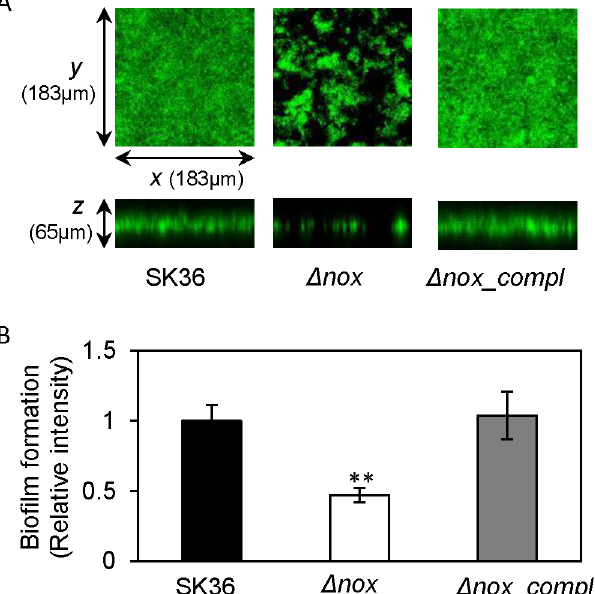
Fig 1. Reduction in biofilm formation in the nox mutant as assessed by confocal laser scanning microscopy. A, biofilm formation on a polystyrene surface detected using a confocal laser scanning microscope. B, quantification of biofilm formation in A. Δ nox , the nox mutant; Δ nox_compl , the complemented strain of the nox mutant. ** , significant difference with P < 0.01 between SK36 and nox mutant. Data obtained at least in